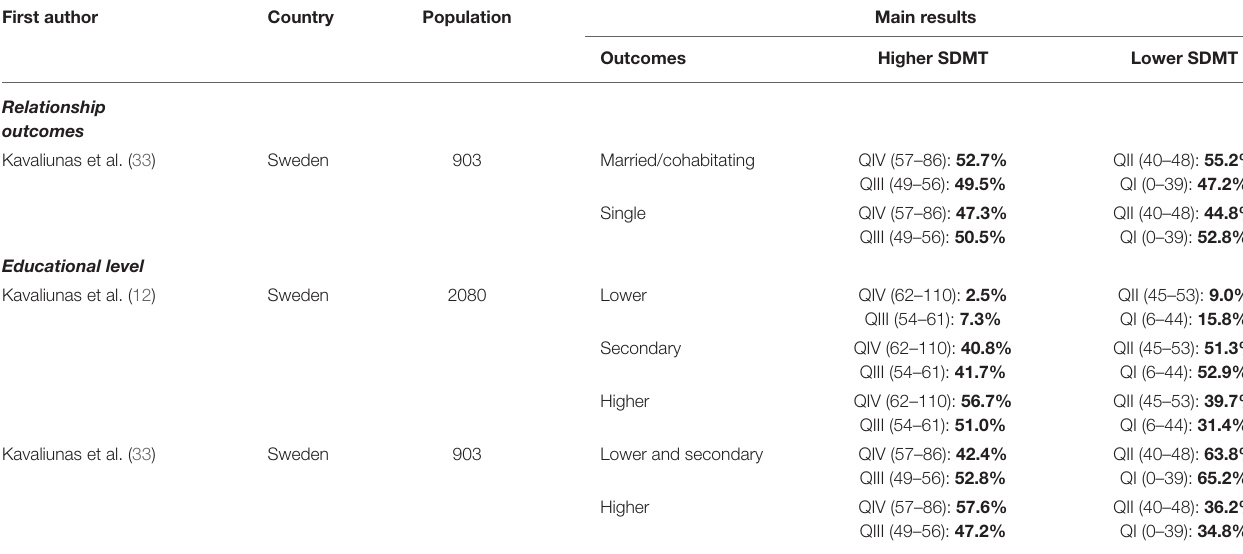
TABLE 9 | Studies that investigated relationship outcomes and educational level in patients with MS within different levels of cognitive